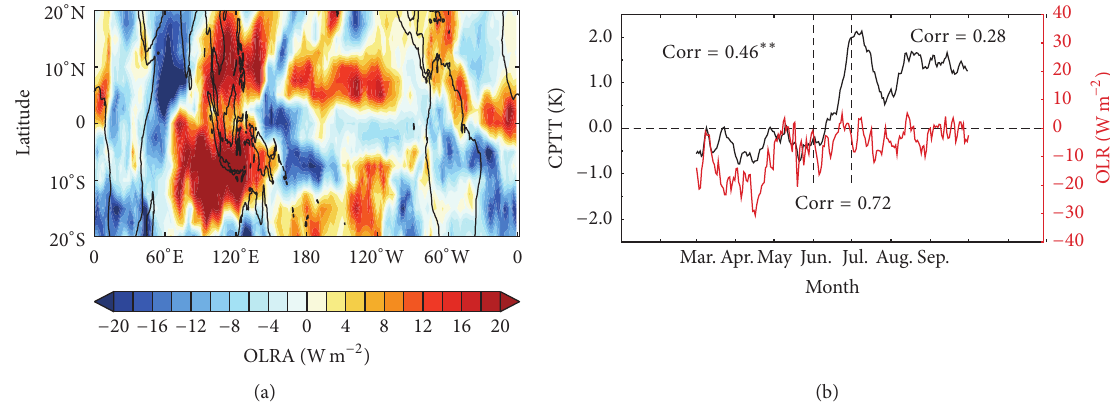
Figure 3: (a) Same as Figure 2(c) but for OLR. (b) Daily time series of CPTT (black line) and tropical eastern Indian Ocean and western PacificOceanaveragedOLR(redline)in1999.“Corr”representsthecorrelationcoefficientbetweenCPTTandOLRduringthe“prewarming,” “warming,” and “postwarming” periods. “ ∗∗ ” indicates correlation coefficients that are significant at the 95% confidence